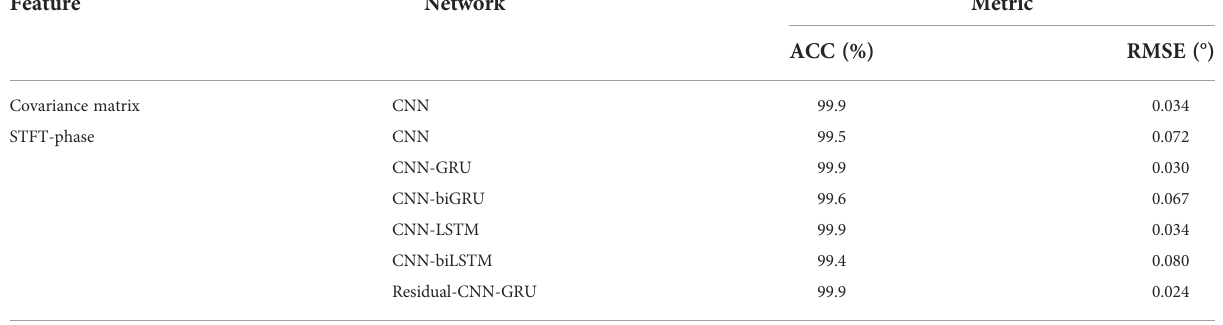
TABLE 3 Performance comparison of different networks and